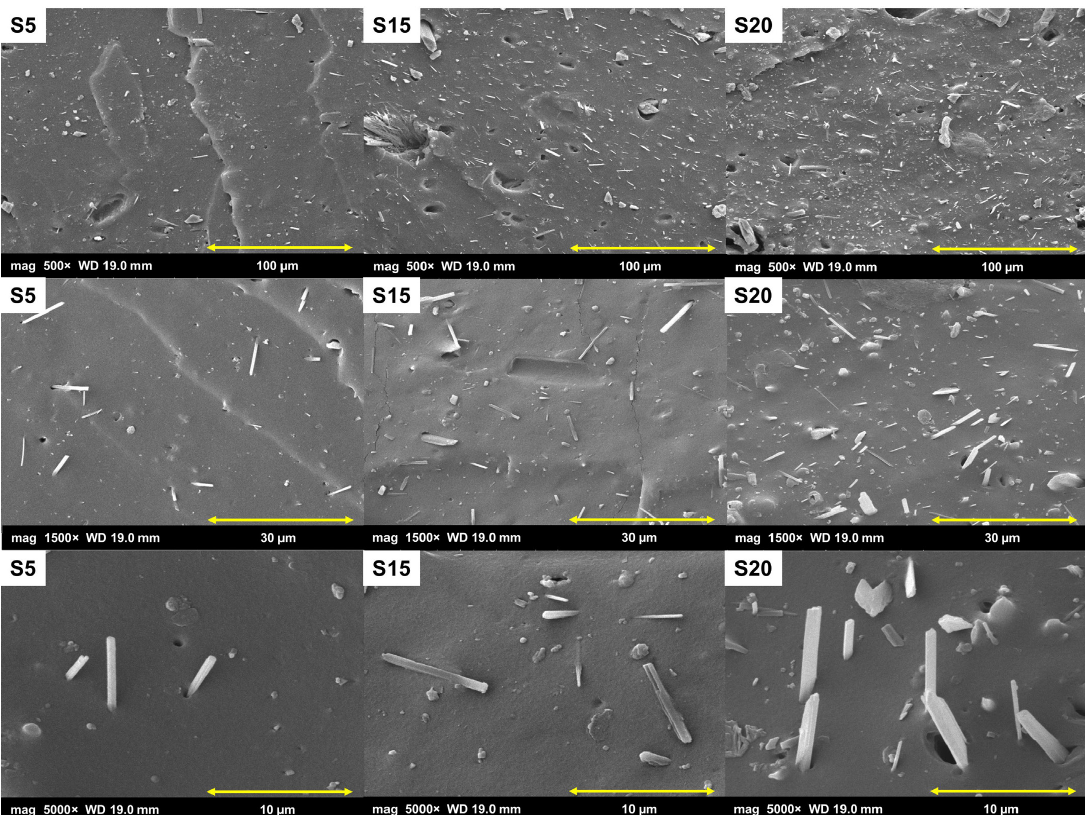
Figure 8. SEM images obtained from tensile fractured surfaces of unfilled and sepiolite filled NR composites at 500×, 1,500× and 5,000×